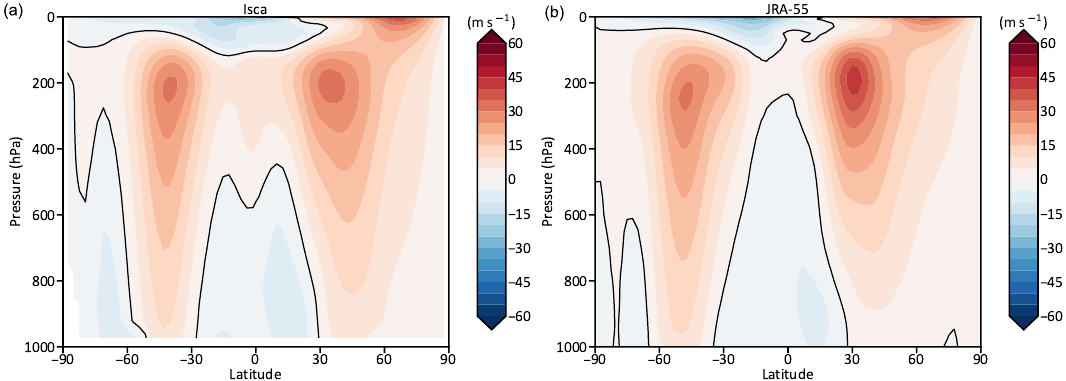
Figure 6. Zonal mean zonal wind in Isca (a) and from a reanalysis, JRA-55 (Kobayashi et al., 2015, b ). The Isca results are an average over 20 years with parameters as described in the text, and JRA-55 shows an average between 1958 and 2016. The thick black line is the zero contour.